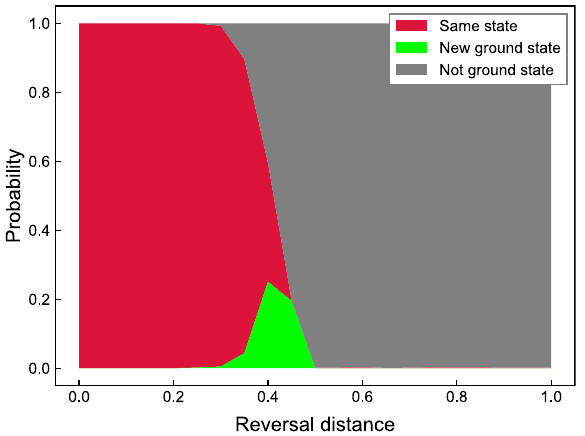
Figure 1. Calibration of reversal distance. We performed reverse annealing on 10 random nontrivial QUBO problems that appeared while running the algorithm with 20 AGVs and analyzed the energies of each of the 1000 samples. For a given reversal distance, the height of the red, green, and gray areas represents the mean probability of attaining the same state, the ground state, and the other state, respectively.